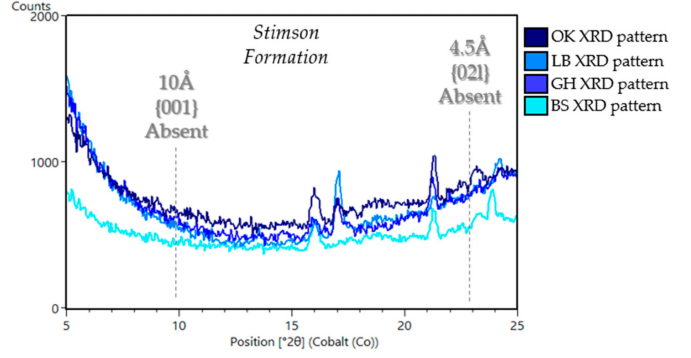
Figure 19. CheMin XRD patterns from 5 ◦ to 25 ◦ 2 θ of samples from the Stimson formation. The basal d-spacing peaks of the d(001) and d(02l) are absent in the Stimson samples, which indicates the absence of phyllosilicates in these samples.